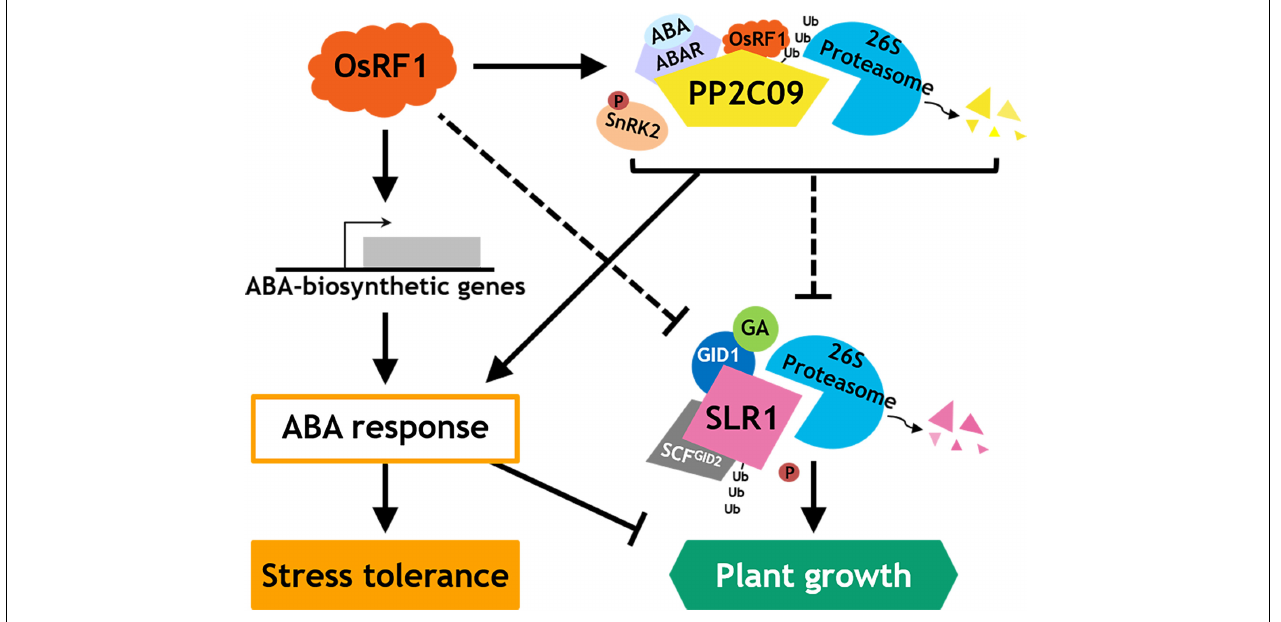
FIGURE 8 | Proposed model for action of OsRF1 in ABA signaling, stress response, and growth